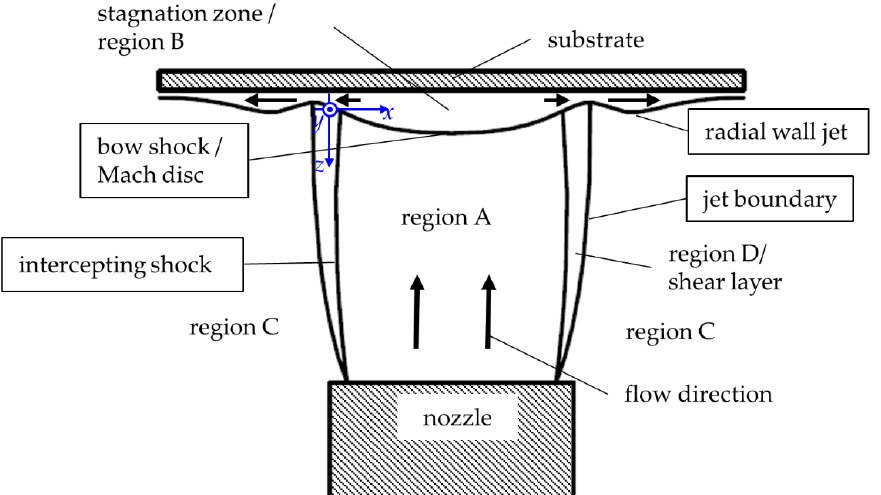
Figure 3. Scheme of the gas expansion between nozzle and substrate, including the different flow regions (region A to D) of the flow pattern, that are bounded by the shock waves (Mach disk, intercepting shock, jet boundary, radial wall jet). Modified from [13,24].